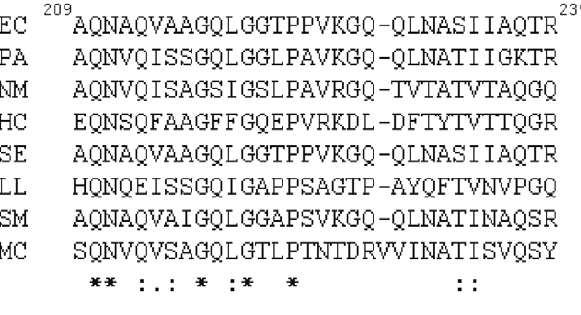
Figure 2. Sequence alignment of the loop. The numbers indicate positions of the starting and ending residues in the sequence of E. coli AcrB. Asterisks, colons and periods indicate identical, conserved and semi-conserved residues, respectively. The sequences are: EC, AcrB from E. coli ; PA, MexB from Pseudomonas aeruginosa PAO1 ; NM, MtrD from Neisseria meningitidis 8013 ; HC, hypothetical protein HcanM9_00968 from Helicobacter canadensis MIT 98-5491 ; SE, acridine efflux pump from Salmonella enterica subsp. enterica serovar Typhimurium str. LT2 ; LL, acriflavine resistance protein B from Legionella longbeachae D-4968 ; SM, hydrophobe/amphiphile efflux-1 (HAE1) from Tenotrophomonas mal- tophilia R551-3 ; MC, RND system efflux pump AcrB from Moraxella catarrhalis RH4 .